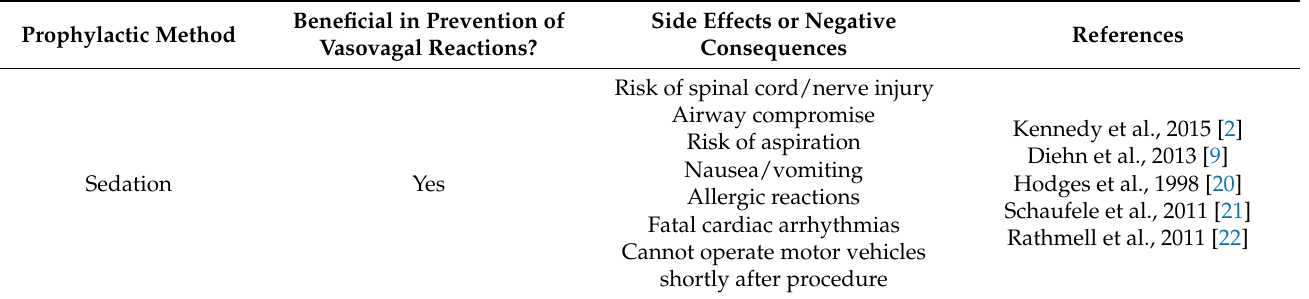
Table 6. Summary of prophylactic methods for vasovagal